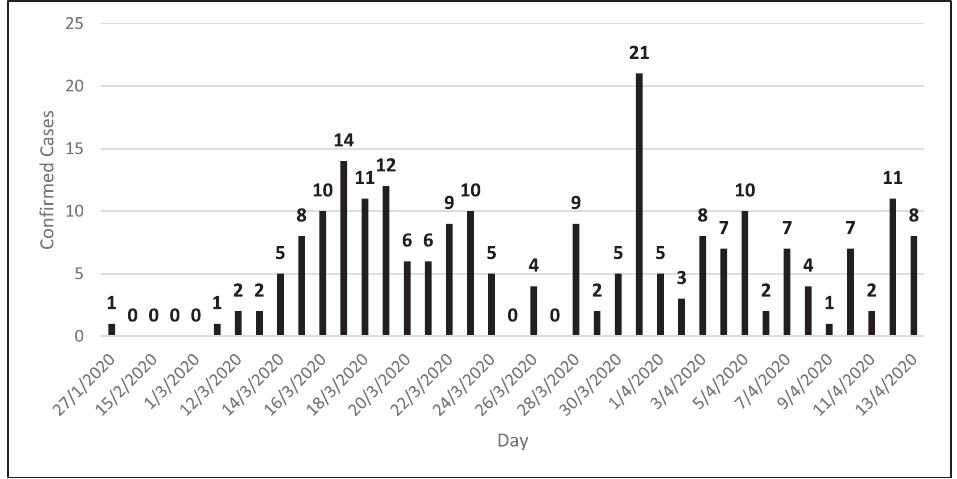
Figure 1: Distribution of the infected persons of COVID-19 detected in Sri Lanka